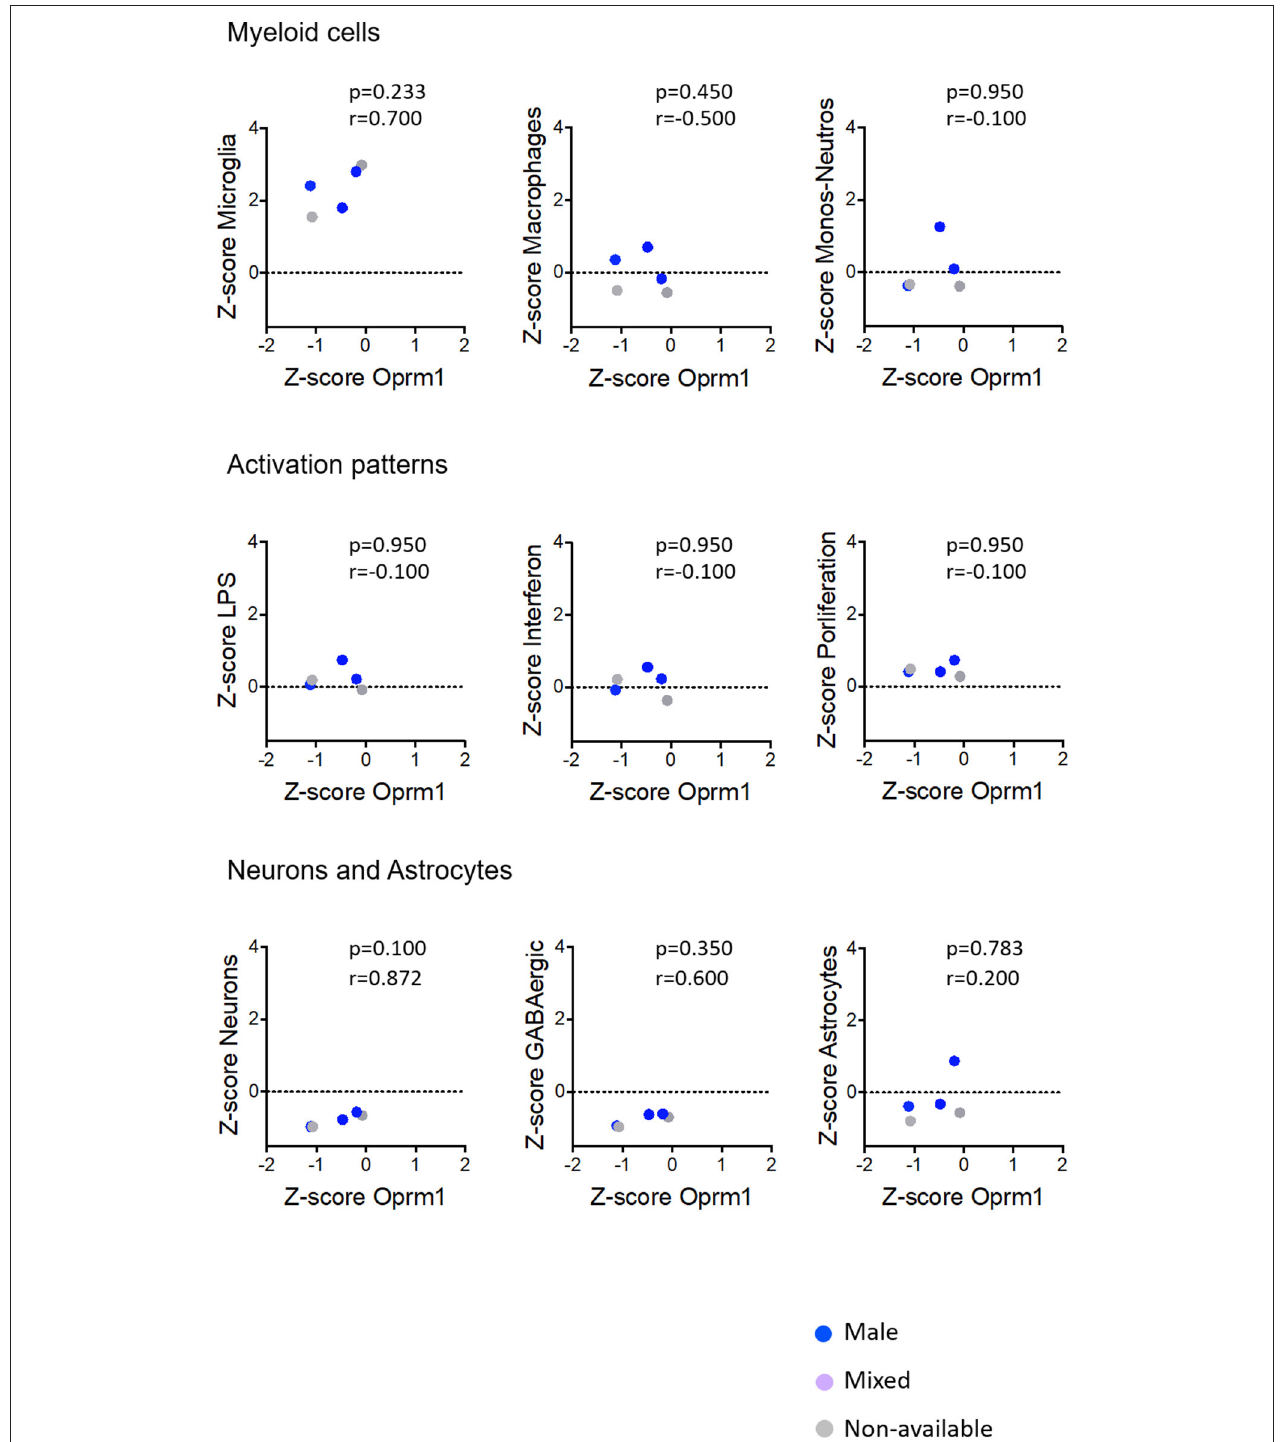
FIGURE 8 | Correlation of Oprm1 gene expression within the Myeloid cells, Activation patterns, and Neurons and Astrocytes gene clusters in rodent spinal cord datasets. Oprm1 expression has a positive correlation ( r = 0.700) with the Microglia-related genes but which is not statistically significant ( p > 0.05, ns). Oprm1 expression is negatively correlated ( r < 0) with Macrophages, Monocytes-Neutrophils- related genes, and Activation patterns gene clusters, but this is not statistically significant ( r < 0 ; p > 0.05, ns). Oprm1 expression has a positive correlation with the Neurons ( r > 0.5) which is not statistically significant ( p > 0.05, ns). There is no correlation between Oprm1 expression and Astrocytes gene clusters ( r = 0.2 ; p = 0.783, ns). All correlations were determined with the Spearman’s correlation test.